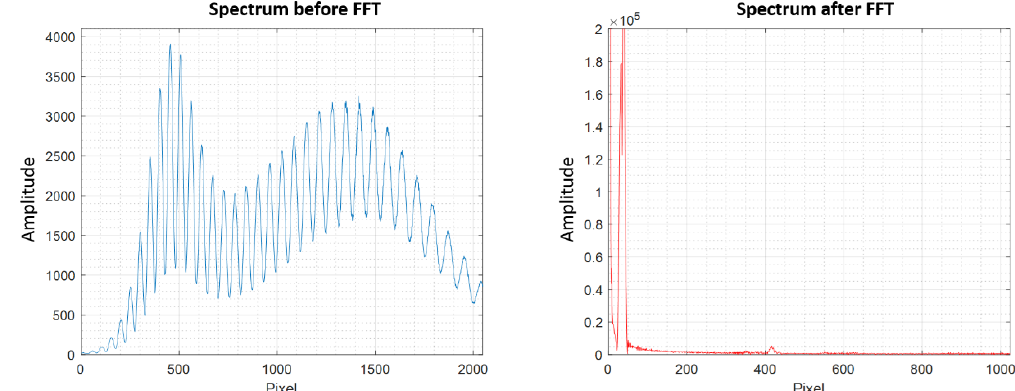
Figure 4. Measurement of a plane mirror with adjusted attenuation of the light intensity. On the left side the raw spectrum is shown. On the right side the peak of the surface is clearly visible.